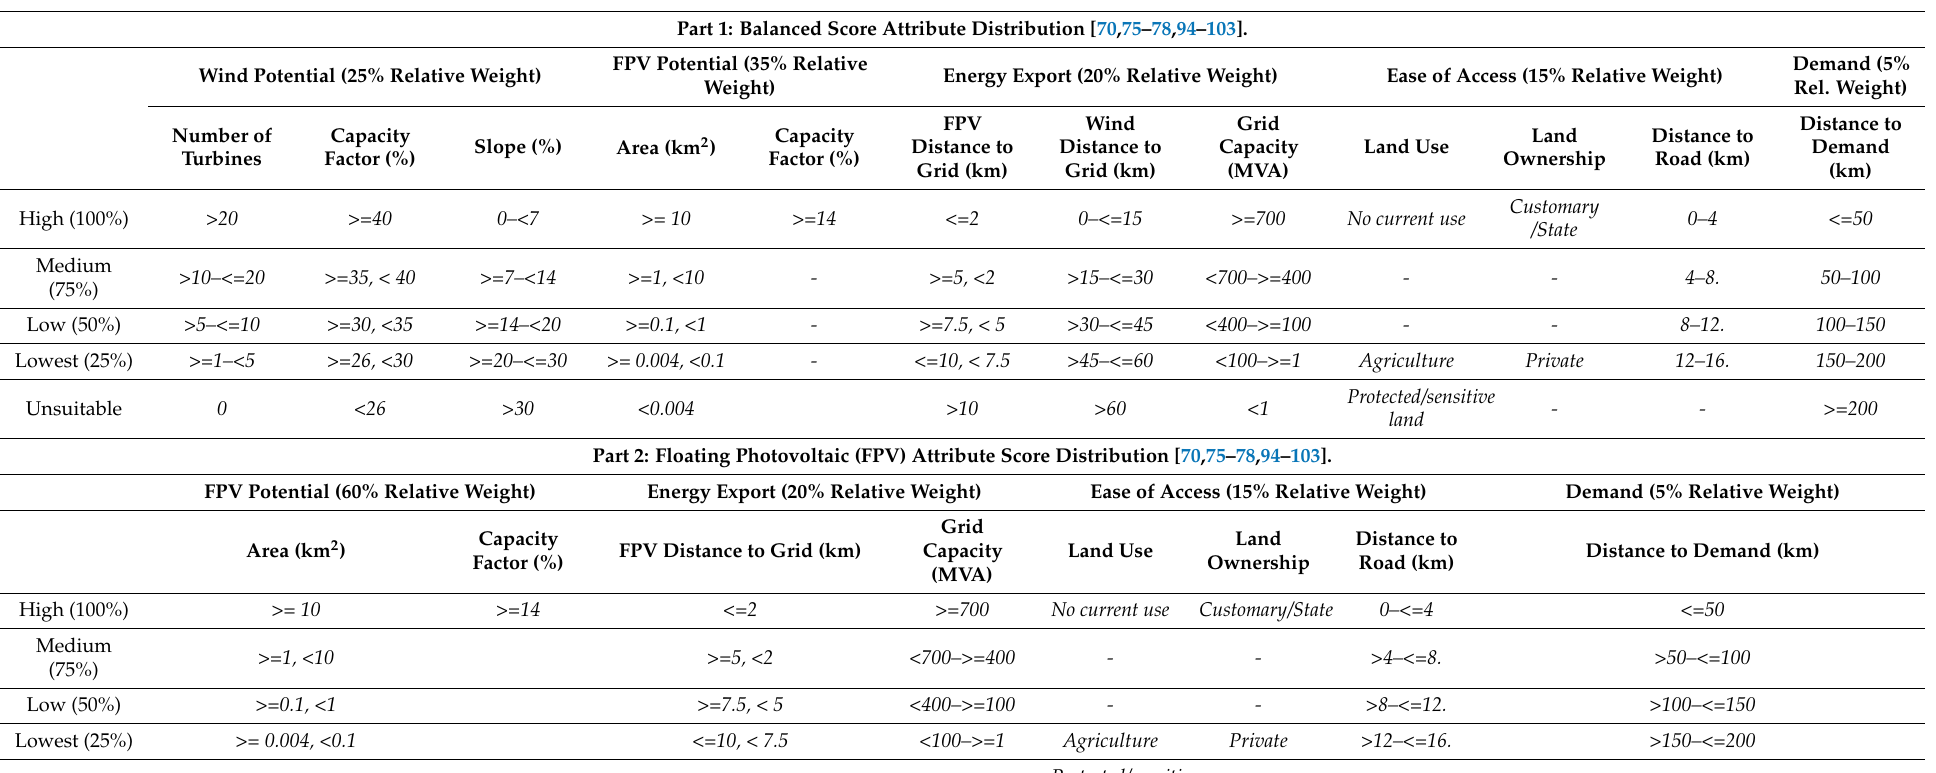
Table A1. Showing the site attribute score for FPV, Wind and